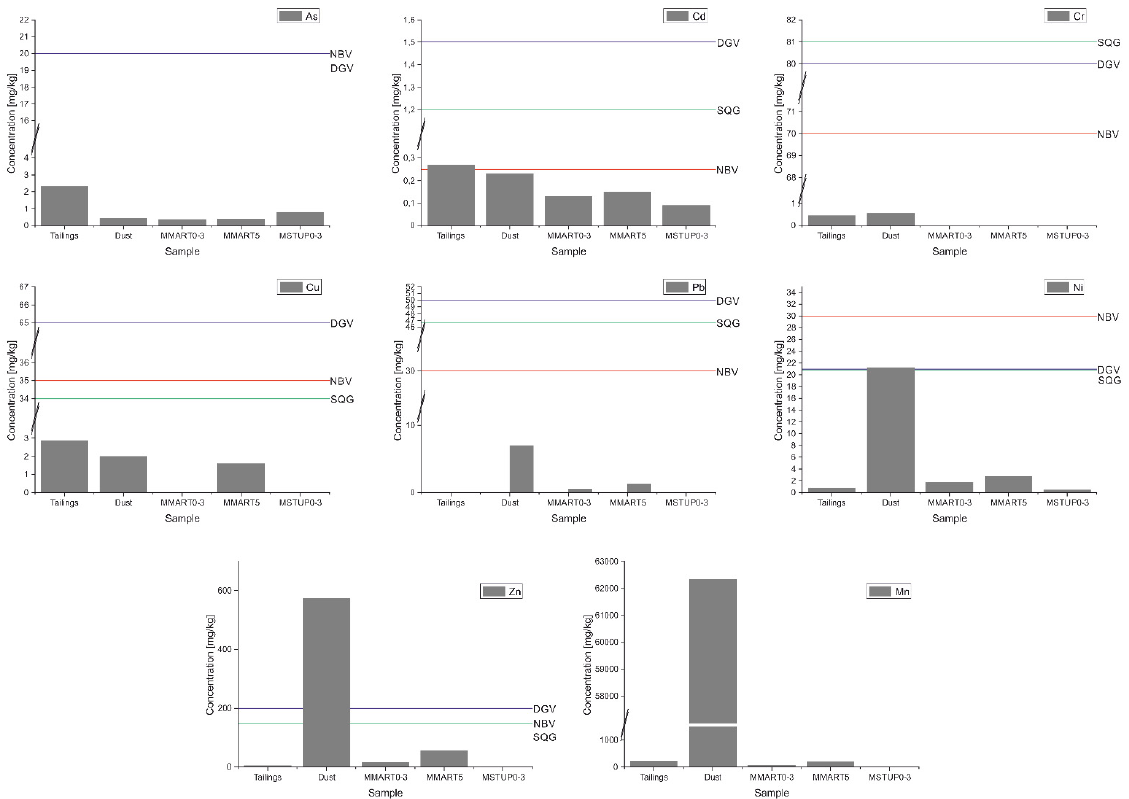
Figure 8. Measured values of the metals in sediment in the first step of BCR sequential analysis (exchangeable fraction) compared to threshold limit values in legislation. NBV—Norway background values [44], DGV—default guideline values [43], SQG—sediment quality guidelines [45].